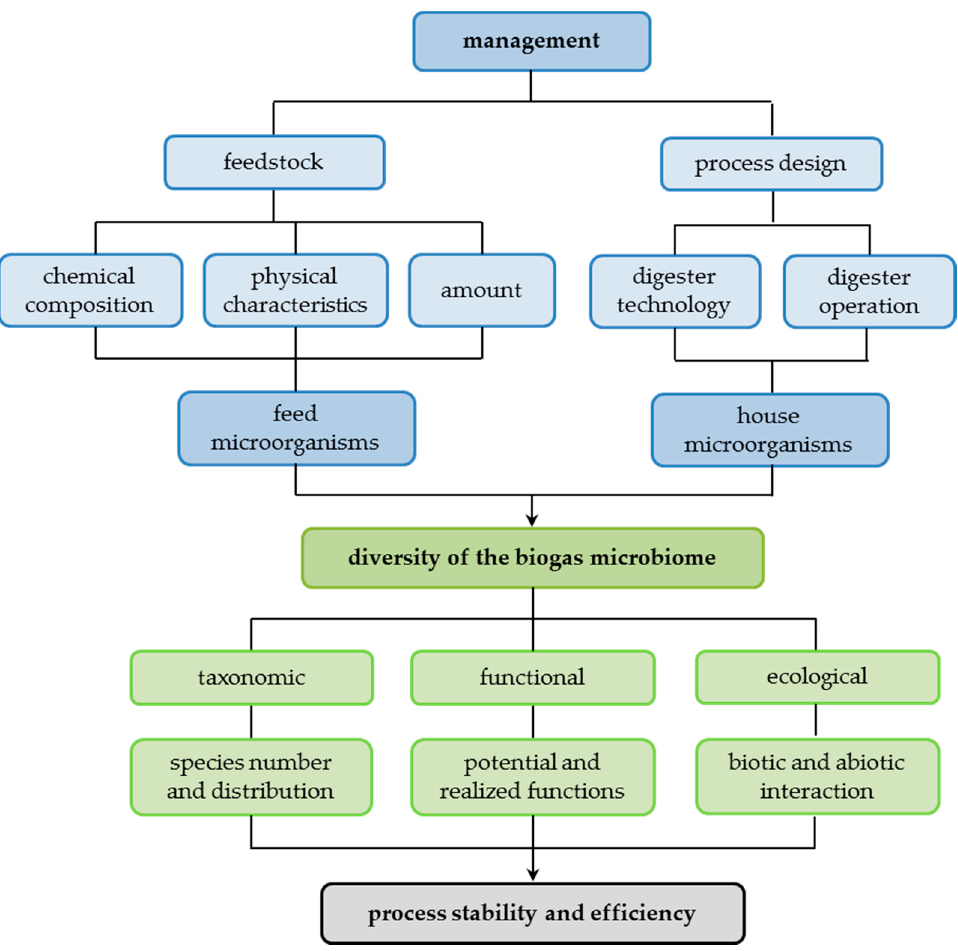
Figure 2. Management of the anaerobic digestion process and diversity levels of the biogas microbiome.